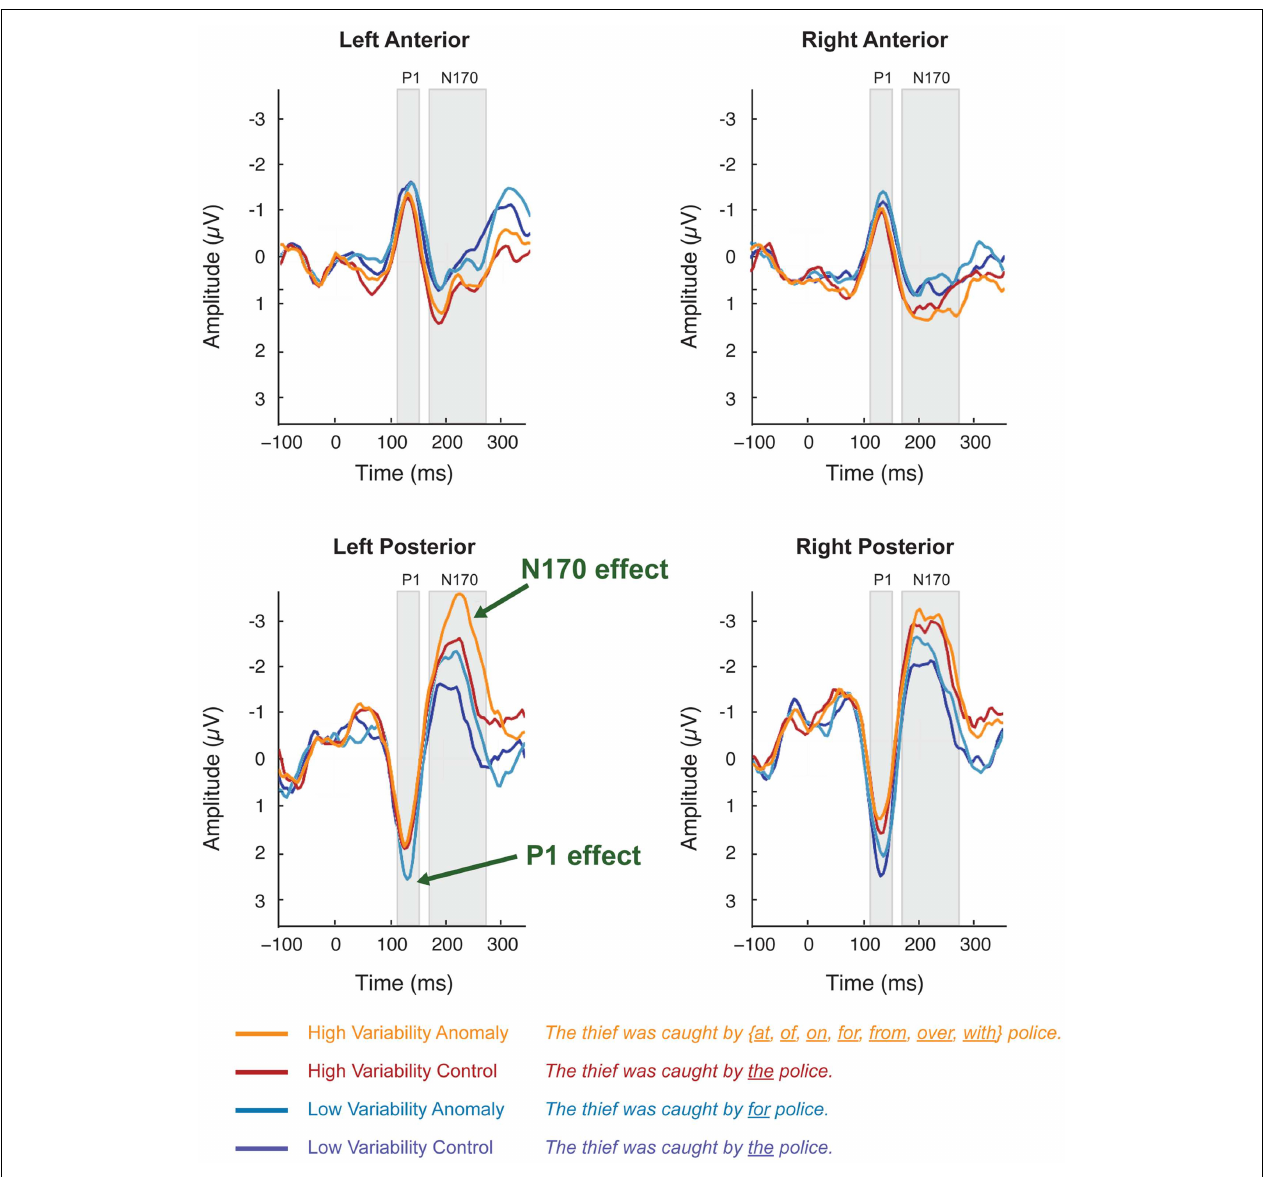
five-channel-group: left-posterior (P07, PO5, P7, CB1, O1), right posterior (P08, PO6, P8, CB2, O2), left anterior (F7, F5, F3, FT7, FC5), right-anterior (F8, F6, F4, FT8, FC6). Scalp ERP waveforms are plotted negative